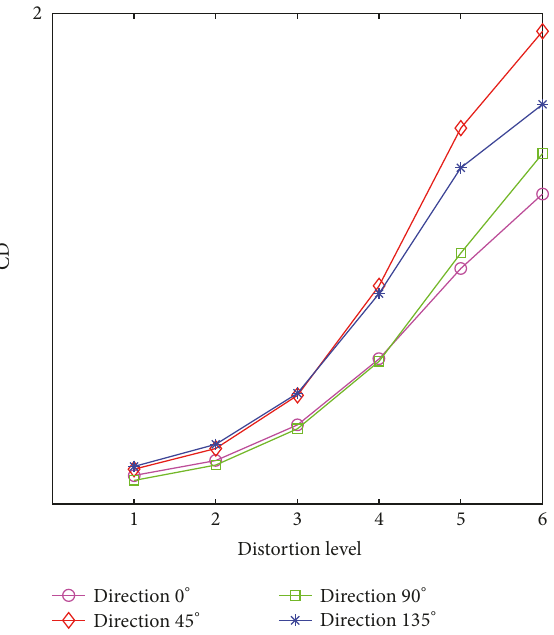
Figure 6: Scatter map of distortion level versus CD in different